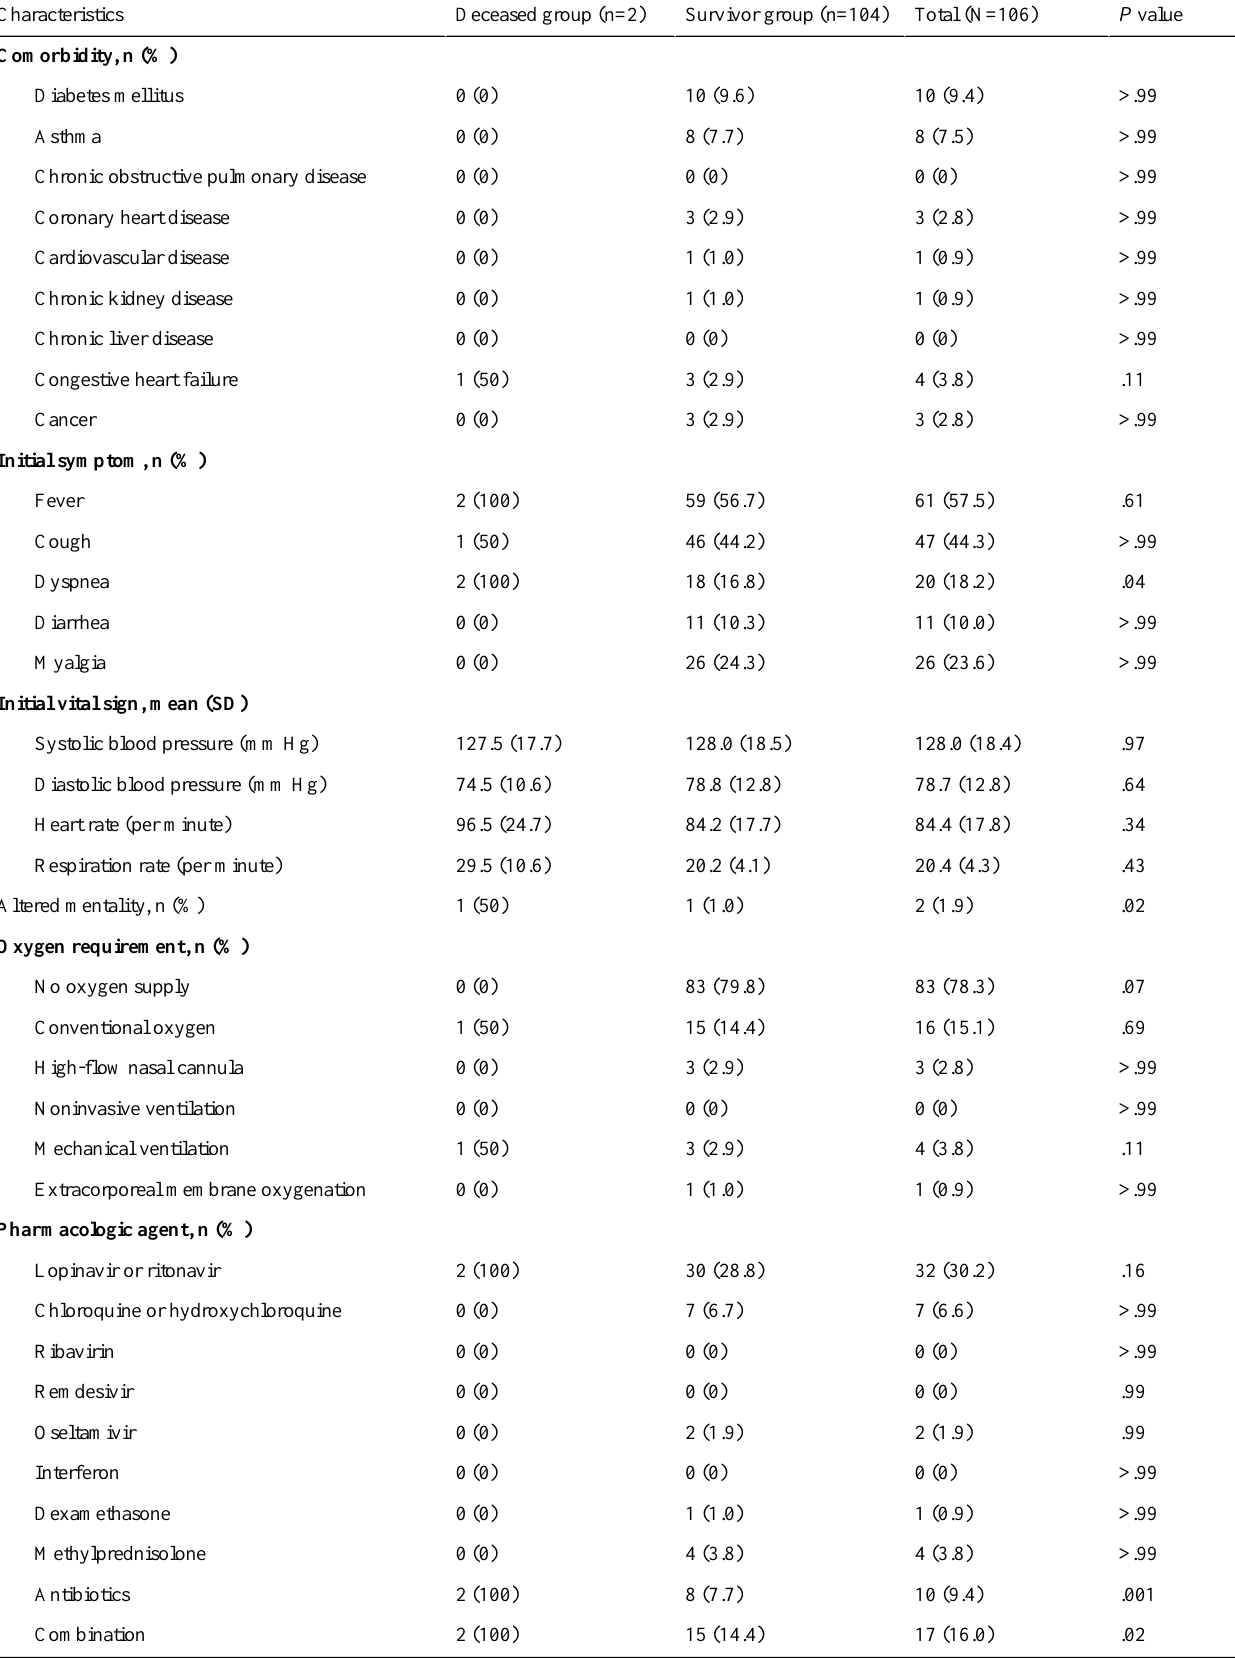
Table 7. Clinical characteristics of the patient groups from the testing data